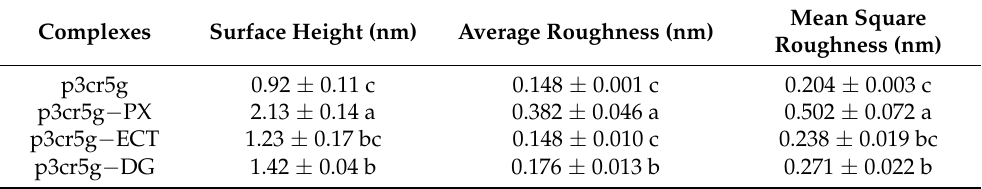
Table 3. Surface height and roughness of p3cr5g compound − binary complex.